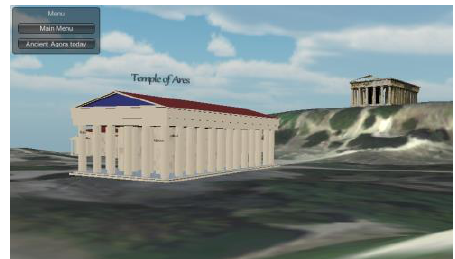
Figure 17: An overview of the game with the GUI